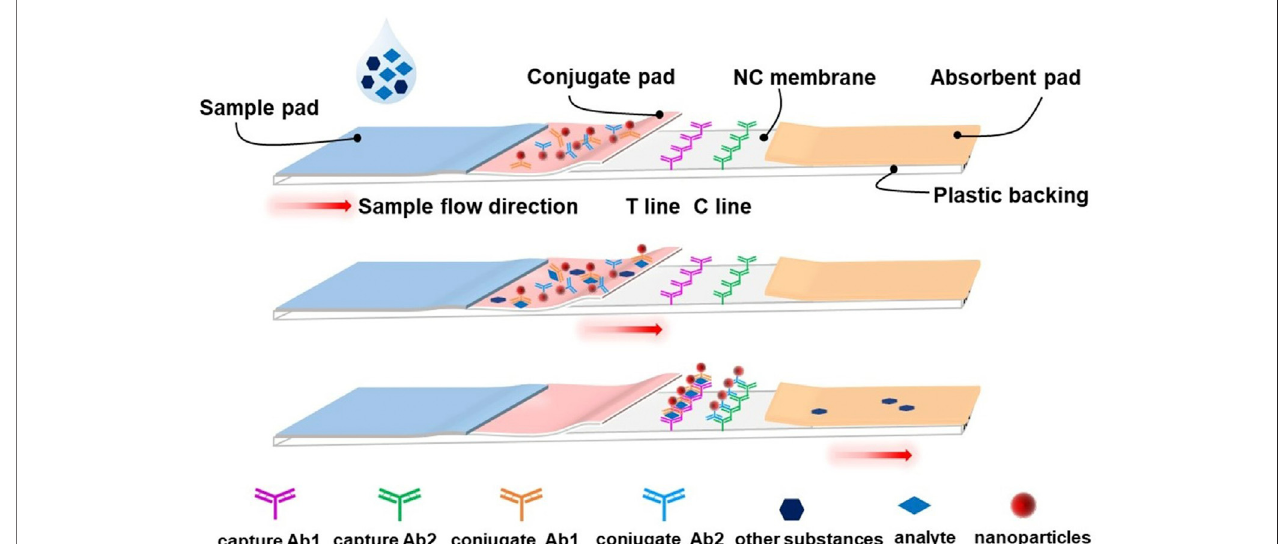
FIGURE 3 | Schematic illustration of a typical lateral fl ow assay strip. The typical lateral fl ow strip is composed of a sample pad, conjugate pad, absorbent pad, nitrocellulose membrane, test line (T line), control line (C line) and plastic backing. The nanoparticles (such as AuNPs) ligated with the conjugate antibody are pre- embedded at the conjugate pad, and the capture antibodies are also pre-embedded on the T line and C line, respectively. Upon loading, the liquid sample will fl ow from the sample pad to the absorbent pad by capillary force. When the analyte passes through the conjugate pad, it will be captured by the corresponding conjugate antibody and form the analyte-conjugate antibody@AuNPs complex. The complexes will be fi xed onto the NC membrane by capture antibody on the T line. Meanwhile, another conjugate antibody will be fi xed on the C line and serve as a control.